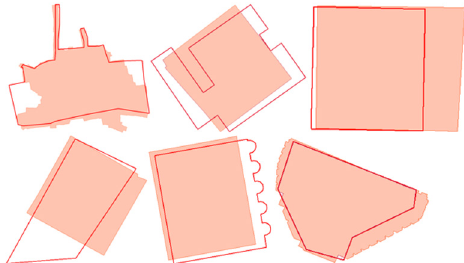
Fig. 10. Some examples of the TOPO (salmon) and OSM (red) BF pairs with high differences from geometric